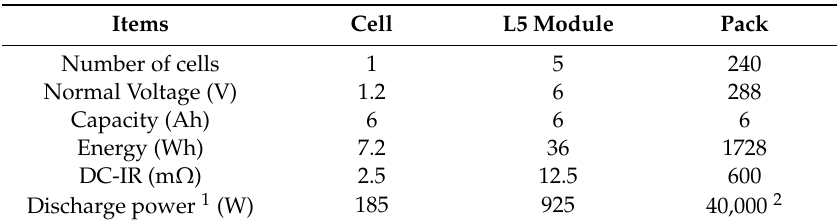
Table 2. Basic performance parameters of the NI-MH cells and pack.